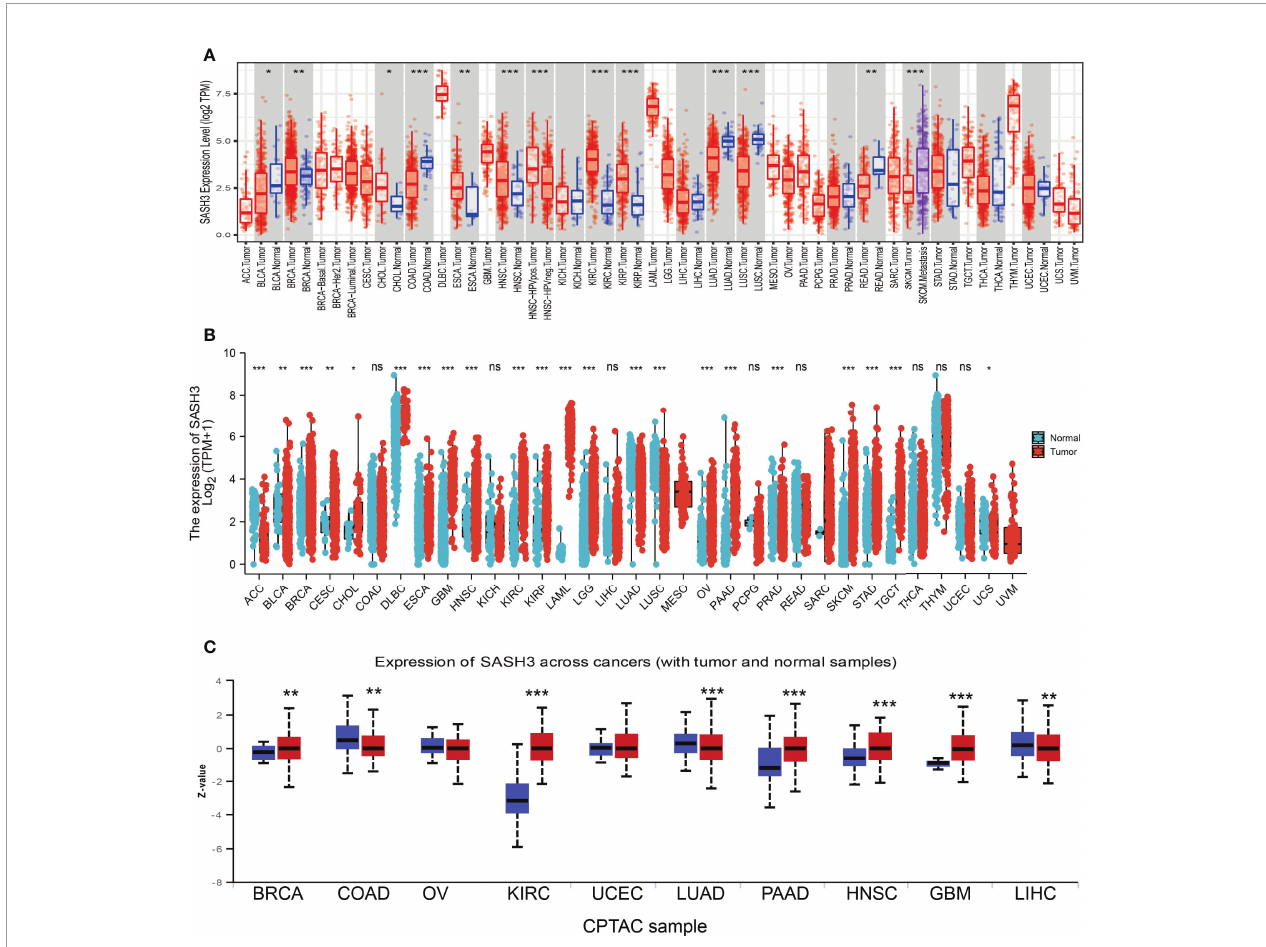
FIGURE 1 | SASH3 expressed differentially between tumor and normal tissues. (A) The expression of SASH3 in pan-cancer analysis by the TIMER database. (B) The expression of SASH3 in pan-cancer analysis by the TCGA/GTEx database. (C) The protein of SASH3 in pan-cancer analysis by the UALCAN database. ACC, adrenocortical carcinoma; BLCA, bladder urothelial carcinoma; BRCA, breast invasive carcinoma; CESC, cervical squamous cell carcinoma and endocervical adenocarcinoma; CHOL, cholangiocarcinoma; COAD, colon adenocarcinoma; DLBC, lymphoid neoplasm diffuse large B-cell lymphoma; ESCA, esophageal carcinoma; GBM, glioblastoma multiforme; HNSC, head and neck squamous cell carcinoma; KICH, kidney chromophobe; KIRC, kidney renal clear cell carcinoma; KIRP, kidney renal papillary cell carcinoma; LAML, acute myeloid leukemia; LIHC, liver hepatocellular carcinoma; LUAD, lung adenocarcinoma; LUSC, lung squamous cell carcinoma; MESO, mesothelioma; OV, ovarian serous cystadenocarcinoma; PAAD, pancreatic adenocarcinoma; PCPG, pheochromocytoma and paraganglioma; PRAD, prostate adenocarcinoma; READ, rectum adenocarcinoma; SARC, sarcoma; SKCM, skin cutaneous melanoma; STAD, stomach adenocarcinoma; TGCT, testicular germ cell tumors; THCA, thyroid carcinoma; THYM, thymoma; UCEC, uterine corpus endometrial carcinoma; UCS, uterine carcinosarcoma; UVM, uveal melanoma. ns, p > 0.05, * p <0.05, ** p <0.01, *** p